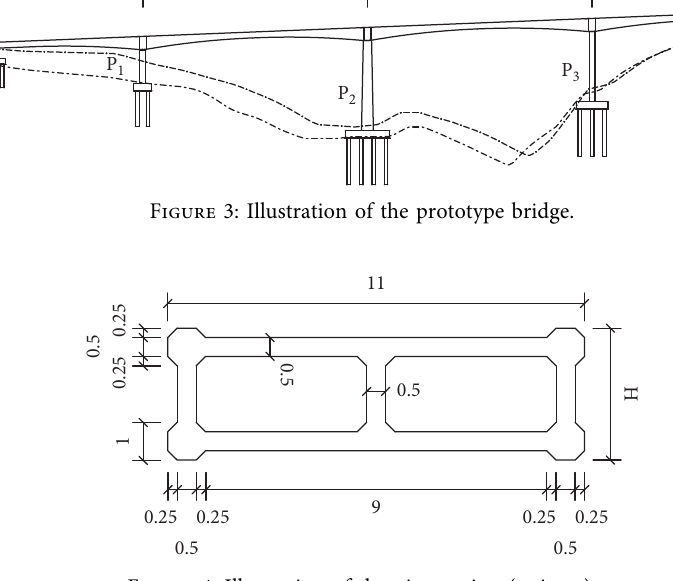
Figure 4: Illustration of the pier section (unit: m).